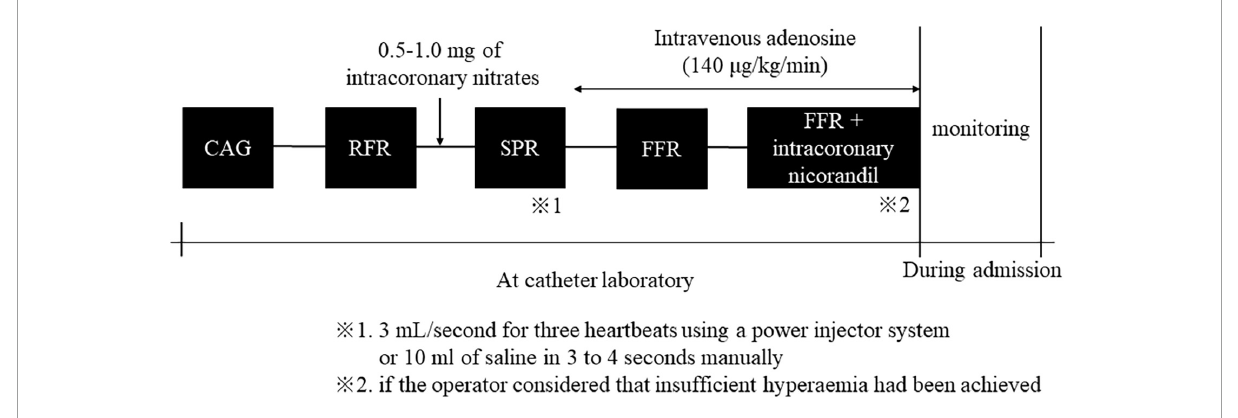
FIGURE1 Outline of pressure measurements protocol. CAG, coronary angiography; RFR, resting full-cycle ratio; SPR, saline-induced Pd/Pa ratio; FFR, fractional flow